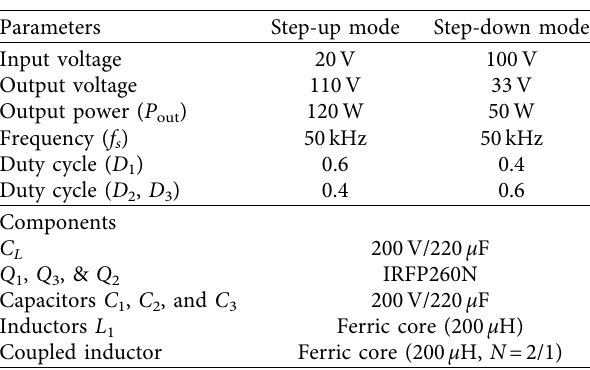
Table 2: Experimental